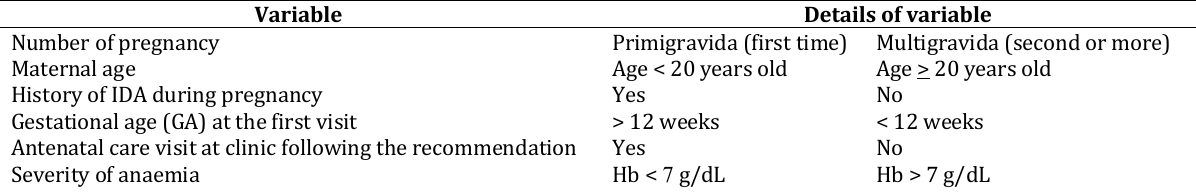
Table 1. Purposive Sampling Frame for Pregnant Women in the Interviews Variable Details of